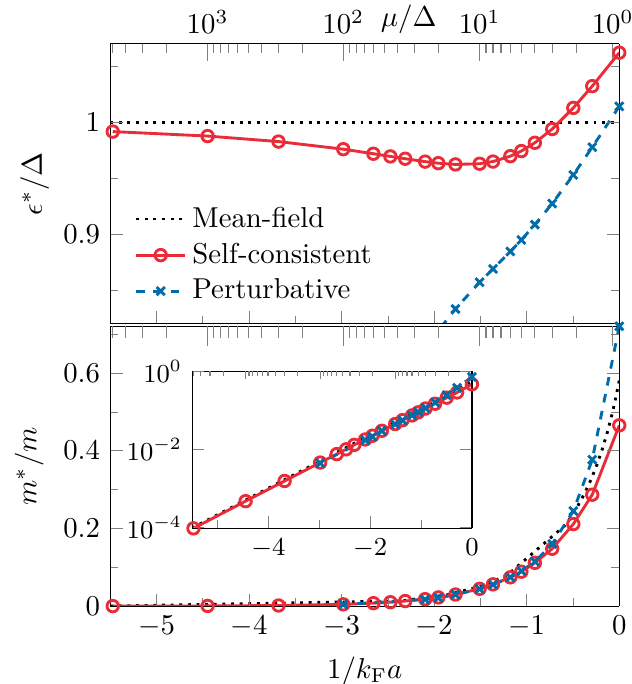
Figure 10: The quasiparticle gap (top panel) and effective mass (bottom panel) in a (bottom axis) or µ/ ∆ (top axis). The red circles function of the interaction 1 / k F show the self-consistent solutions, which are compared to the perturbative results (blue crosses) and the mean-field values (black dotted line). It is clear that the per- turbative calculation leads to wrong results in the BCS limit, as it is not possible to treat the self-energy Σ as a small